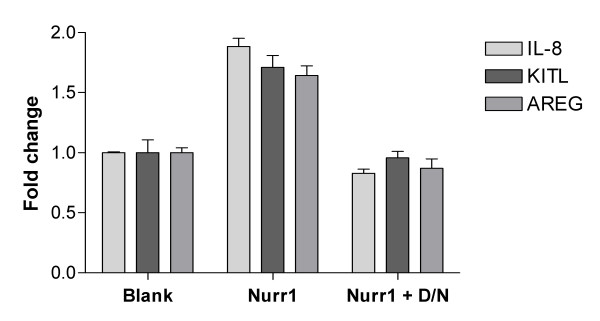
Effect of dominant negative Nurr1 on Nurr1 induced inflammatory gene expression. Demonstration that Nurr1 causes increased expression of IL-8, AREG and KITLG mRNA that can be attenuated with the coexpression of Nurr1-D/N in K4IM cells using Taqman Quantitative RT-PCR. Values expressed represent the mean fold change ± SEM, compared to the blank vector control and is derived from three experiments normalised in each case to GAPDH gene expression at 24 hr post transfection. Similar results were observed in a further two independent experiments.